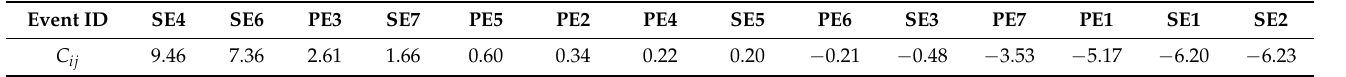
Table 9. Cross-impact ranking of source and process events on resultant event RE1.